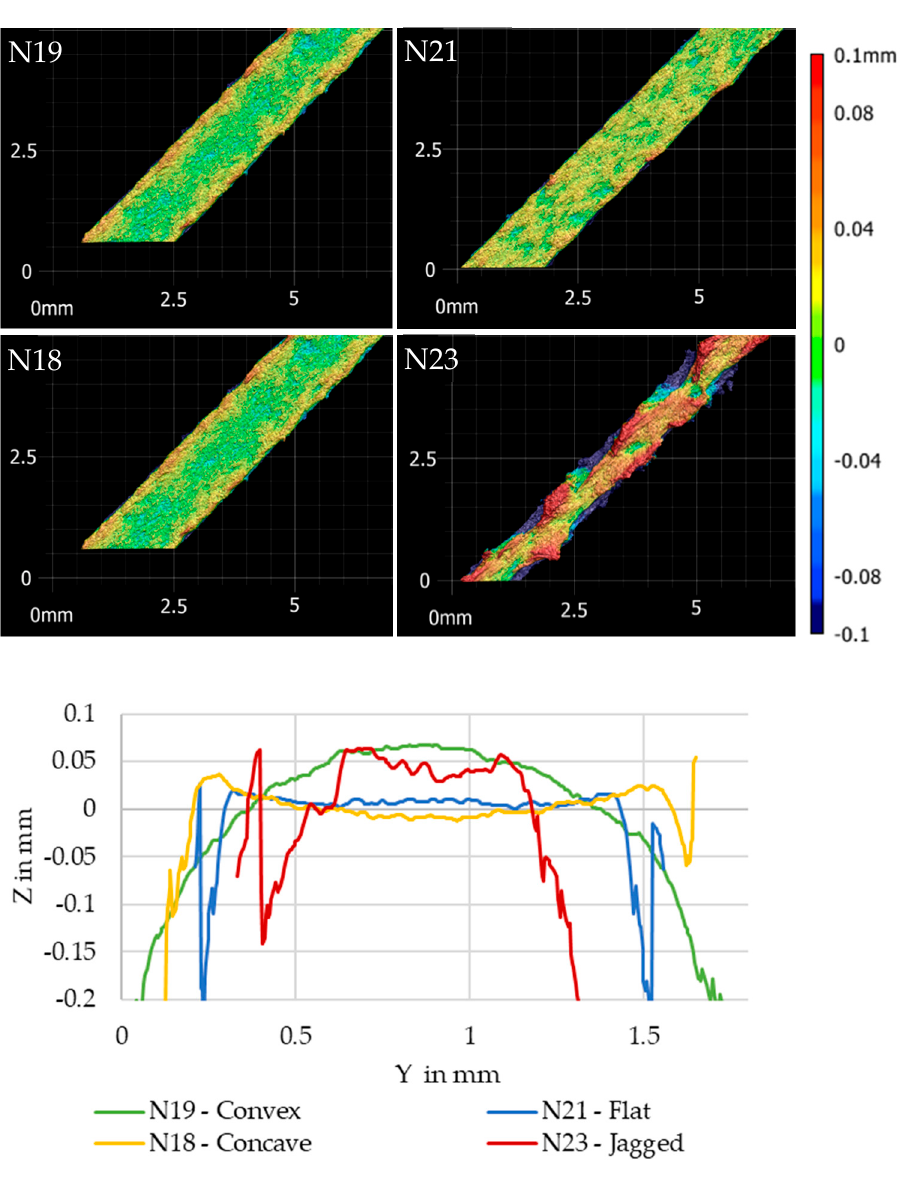
Figure 4. Types of extrusion line shapes and their height profiles.